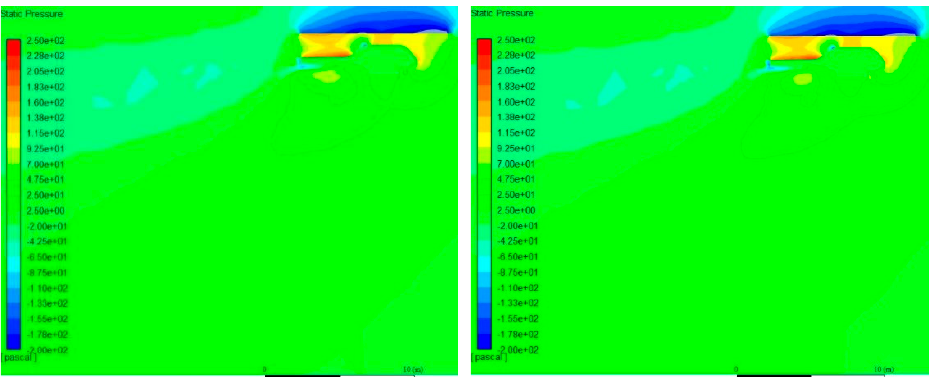
Figure 10. Velocity vector on the longitudinal symmetry plane of the fuselage in the initial scenario (1000 iterations on the left , 2000 iterations on the right ).